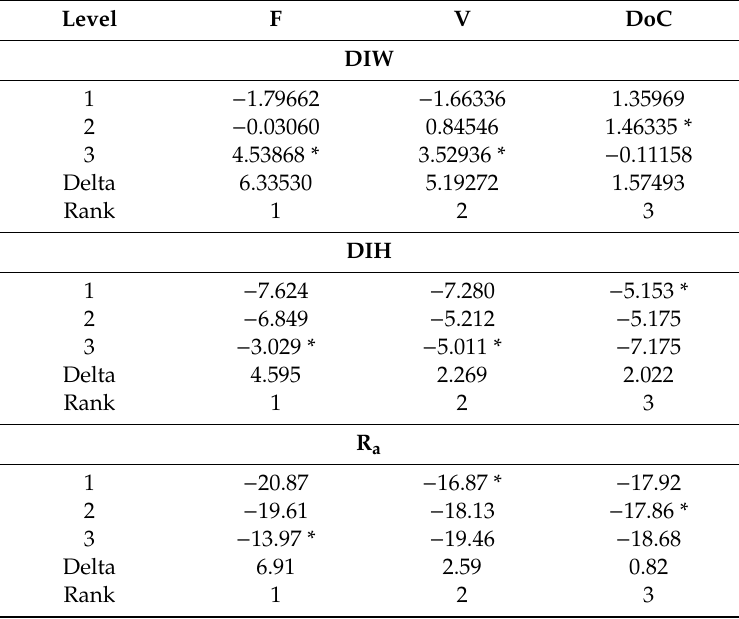
Table 6. Delta rank of S / N responses.